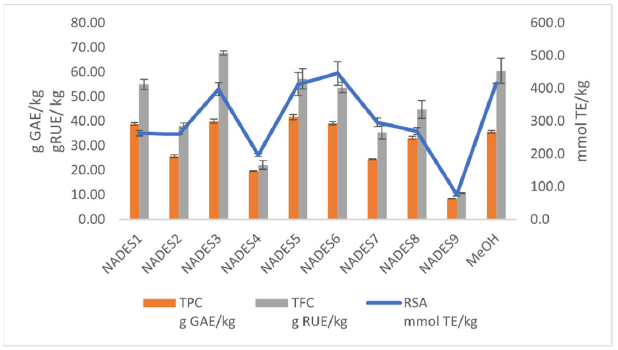
Figure 1. TPC, TFC, and RSA of A. eupatoria obtained using NADES and methanol.